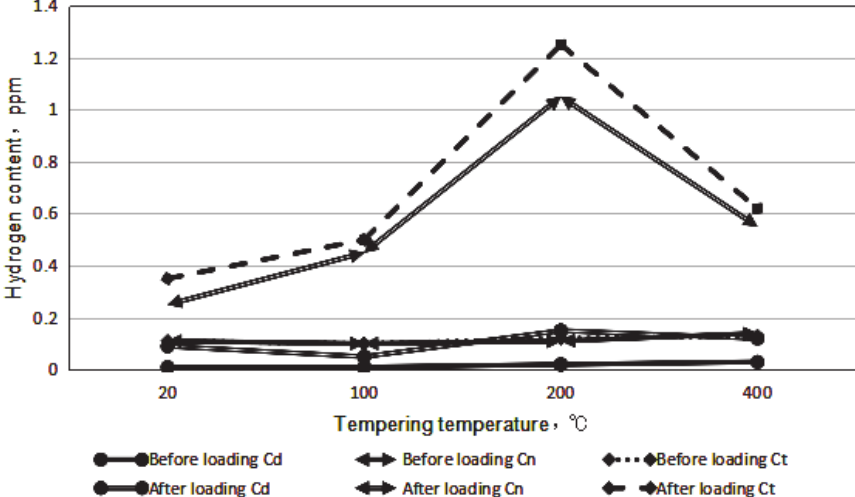
Figure 7: The content of hydrogen of experimental materials in different states before and after loading (plate samples). Activation energy of hydrogen trap of experimental